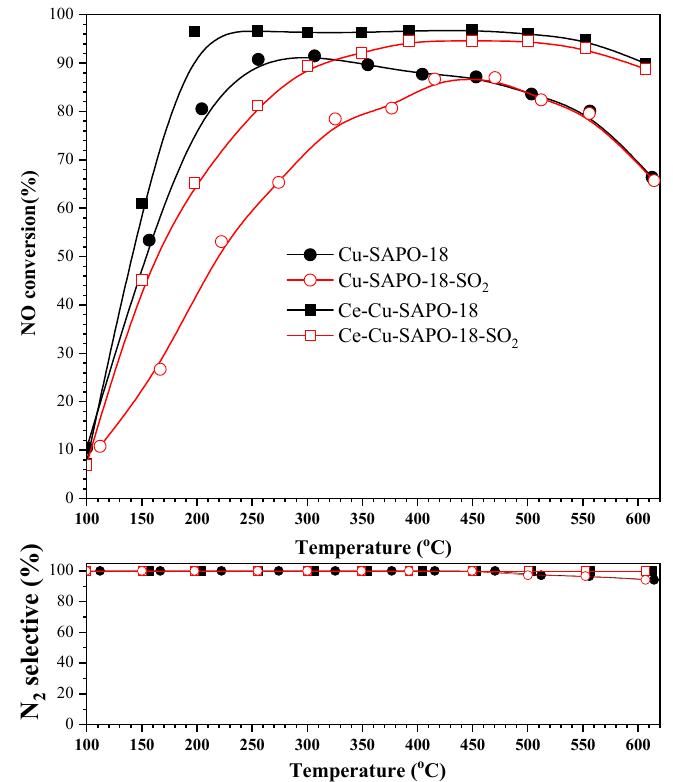
Figure 1. NO conversion and N 2 selectivity during the NH 3 -SCR reaction over the Cu-SAPO-18 and Ce-Cu-SAPO-18 samples at a GHSV of 130,000 h − 1 . The reactant feed composition: 500 ppm NO, 500 ppm NH 3 , 100 ppm SO 2 (when used), 14 vol.% O 2 , 5 vol.% H 2 O, and N 2 (balance).